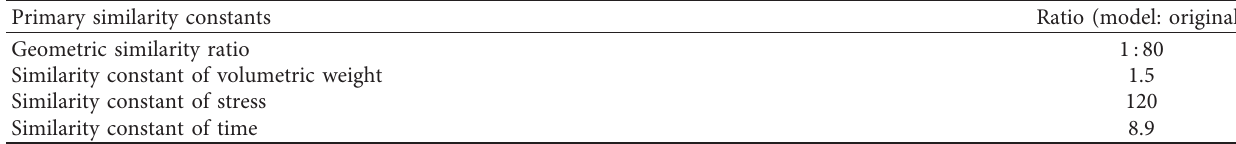
Table 1: Primary similarity constants of similar simulation